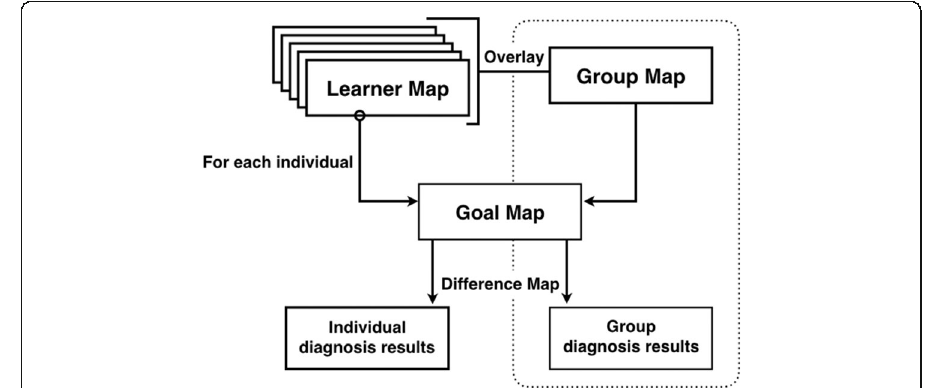
Fig. 4 The analyzer workflow of the Kit-Build concept